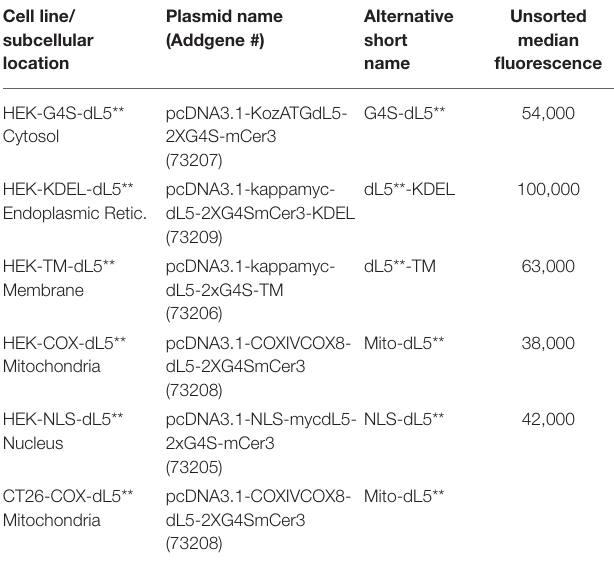
TABLE 1 | Subcellular Locations and Cell Types used, along with Addgene Plasmid Names/Numbers, short names used in this manuscript, and population median fluorescence prior to intensity selection by